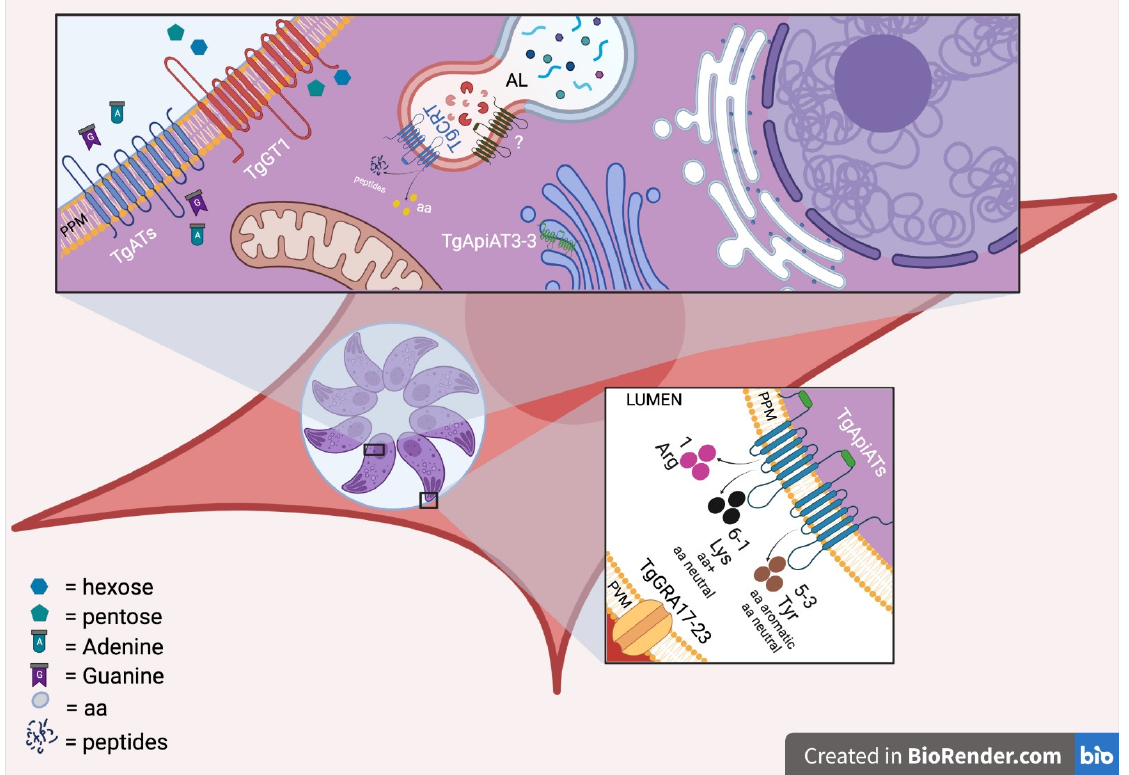
Figure 2. Schematic representation of transporters in intracellular T. gondii tachyzoites. As with P. falciparum , nutrients must also be trafficked across multiple membranes to reach intracellular T. gondii parasites. Known transporters include the following: TgGRA17 and TgGRA23 generate a pore-forming complex on the PVM that facilitates the movement of small molecules across this membrane (lower inset image). Numerous TgApiATs facilitate amino acid transport across the PPM, with different transporters adapted for the movement of specific types of amino acids (lower inset image). TgApiAT3-3 has also been shown to localize to the trans-Golgi network (upper inset image). TgATs and TgGT1 are nucleoside and sugar transporters, respectively, located at the PPM. TgCRT exports small molecules from the plant-like digestive vacuole (the VAC) (upper inset image). No amino acid importer on the VAC has previously been reported. aa— amino acid; aa+—basic amino acid; AL—autophagolysosome; PPM—parasite plasma membrane; and PVM— parasitophorous vacuole membrane.